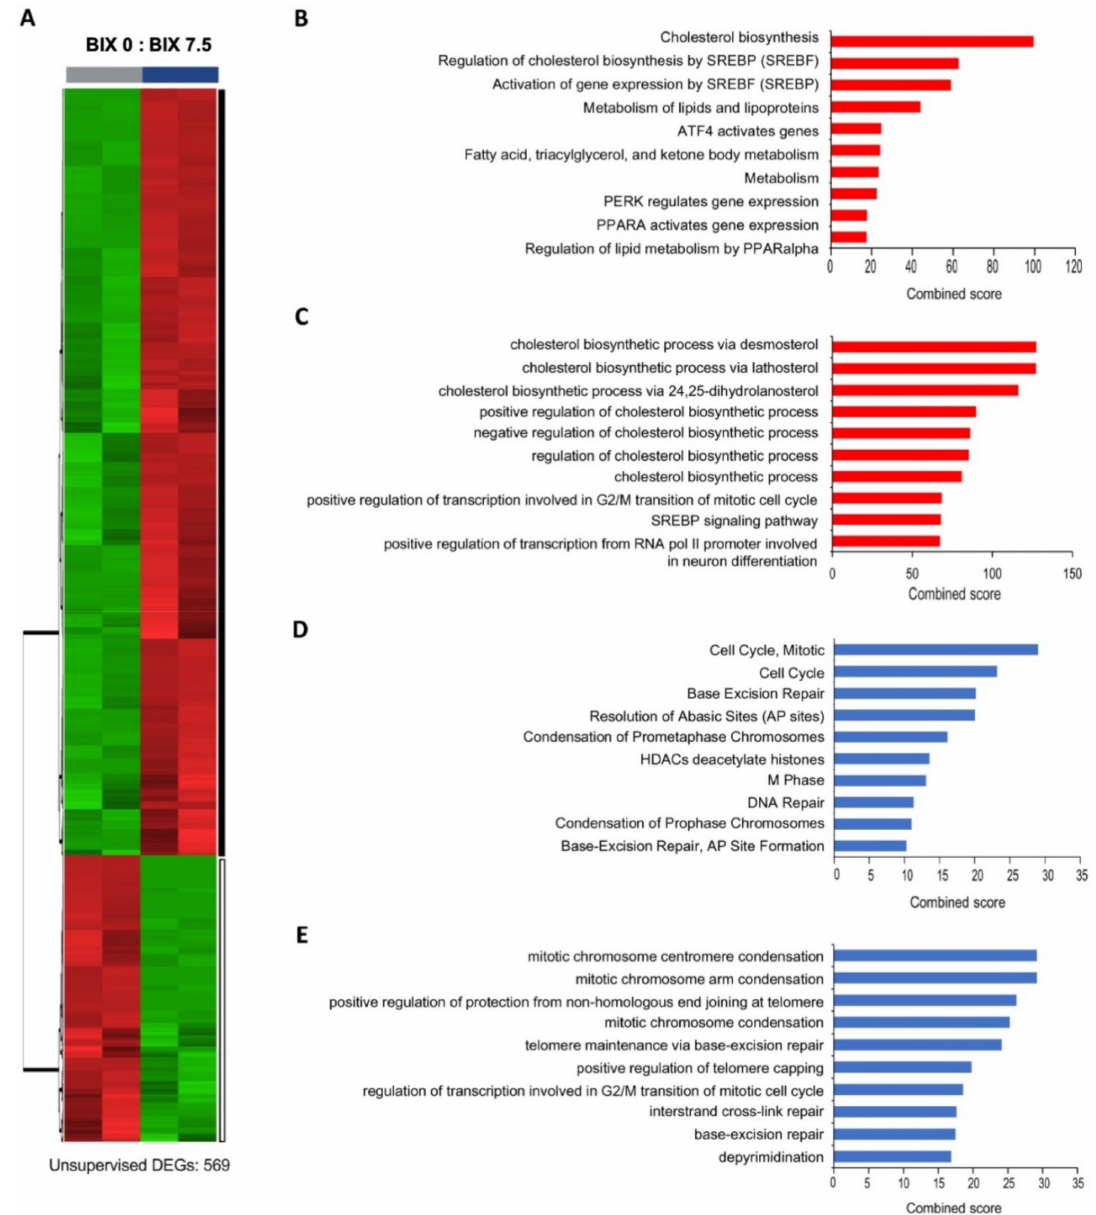
Figure 3. Distinct expression profiles in the BIX-treated H1299 cell line using RNA sequencing. ( A ) The gene expression pattern according to RNA sequencing in heatmap. Black bar: 422 upregulated di ff erentially expressed genes (DEGs). White bar: 147 downregulated DEGs. ( B ) Top 10 Reactome pathways of upregulated genes. ( C ) Top 10 Gene Ontology (GO) biological processes (BPs) terms of upregulated genes. ( D ) Top 10 Reactome pathways of downregulated genes. ( E ) Top 10 GO BP terms of downregulated genes based on combined score obtained from